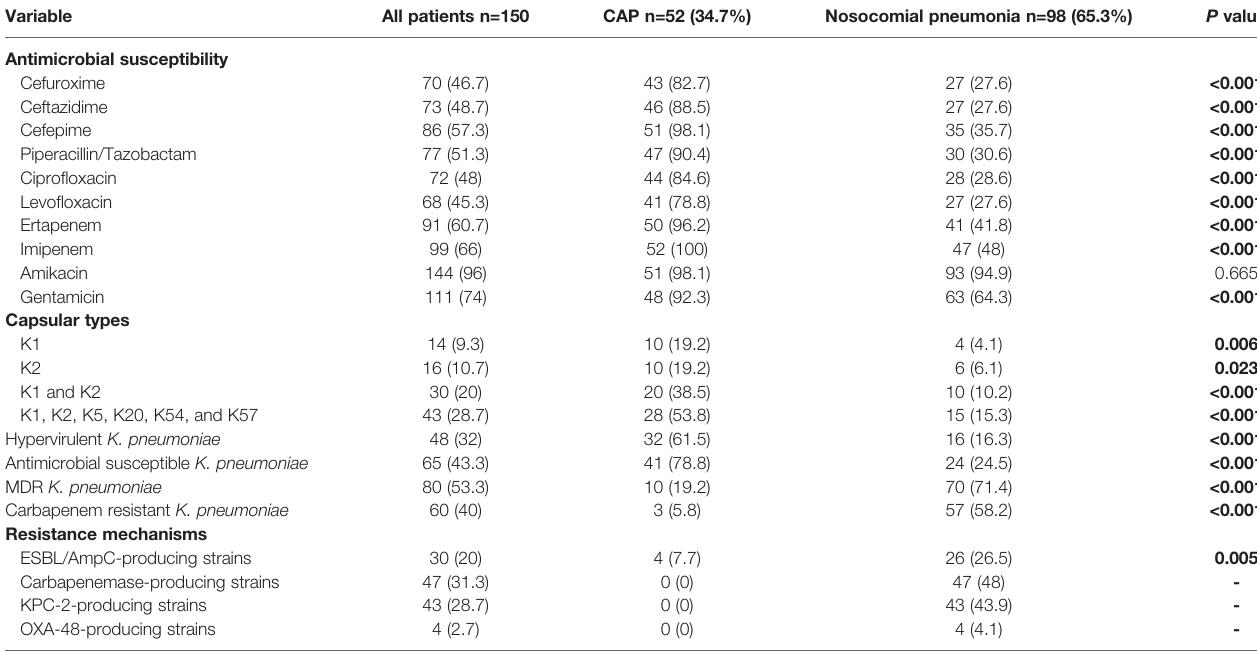
TABLE 2 | Antimicrobial susceptibility and microbiological characteristics of the K. pneumoniae clinical isolates. Variable All patients